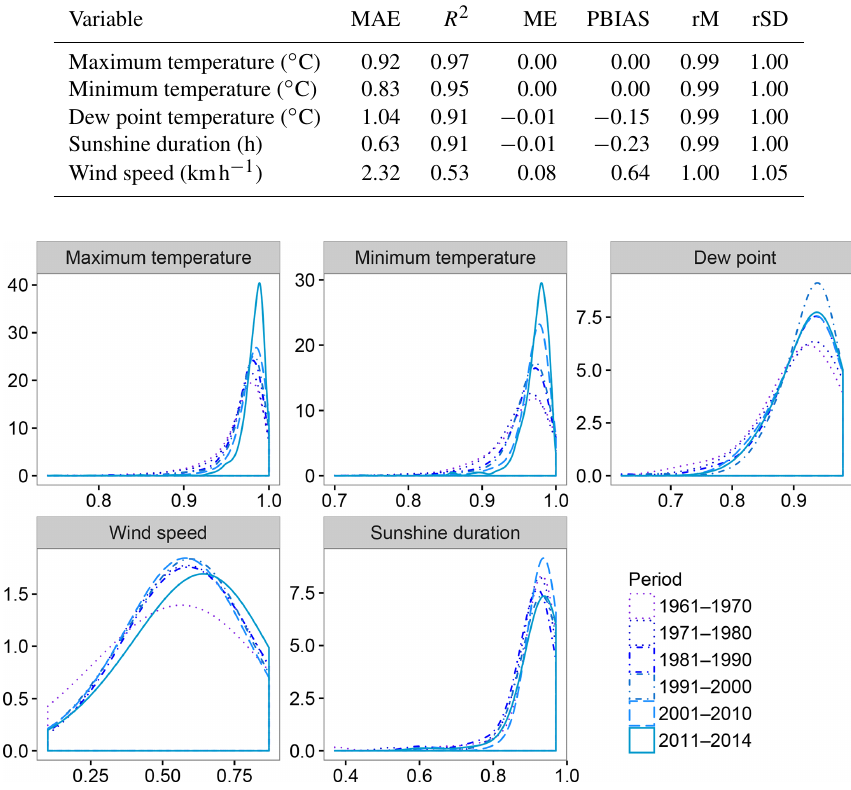
Table 2. Gap-filling statistics. Values for the following validation statistics are provided: (i) mean absolute error (MAE), (ii) coefficient of determination R 2 , (iii) mean error (ME), (iv) percent bias (PBIAS), (v) ratio of mean values (rM) and (vi) ratio of standard deviation (rSD).